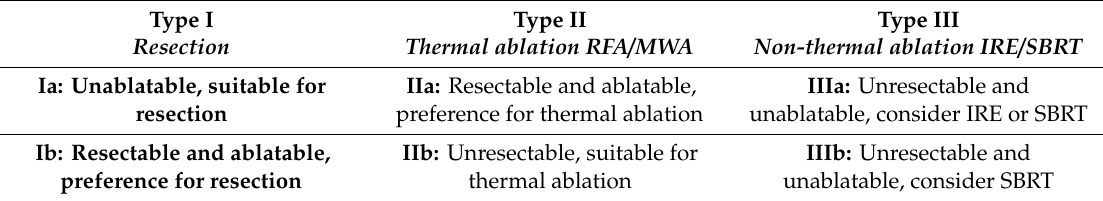
Table 1. Type of CRLM for which locoregional therapy should be